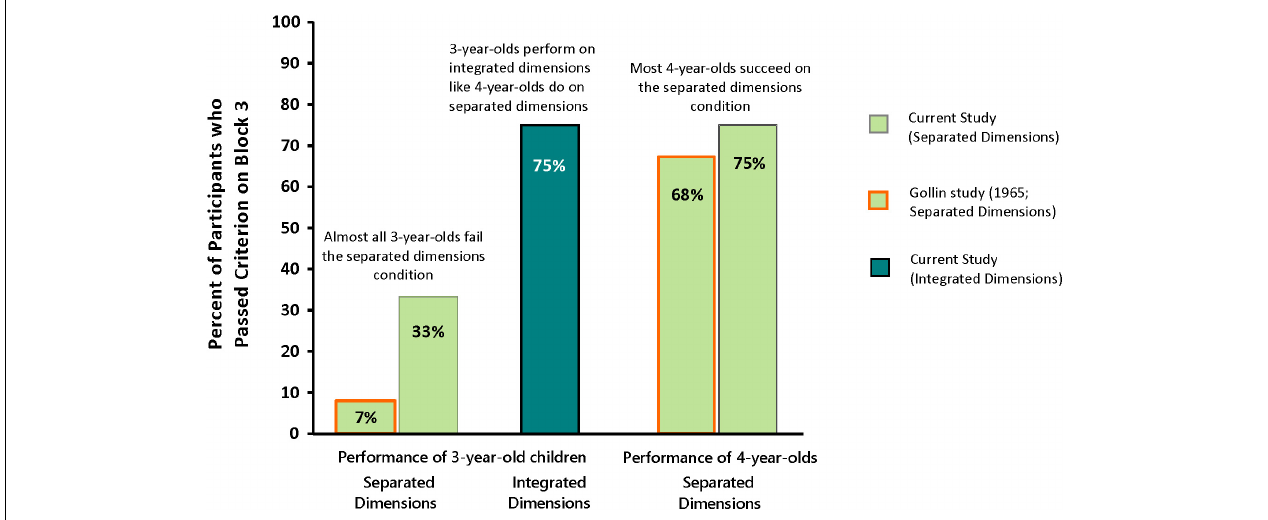
FIGURE 3 | Percentage of Children 3 and 4 years old who Succeeded on Block 3 of the Conditional Discrimination Task in our study and in Gollin’s (1965) study.